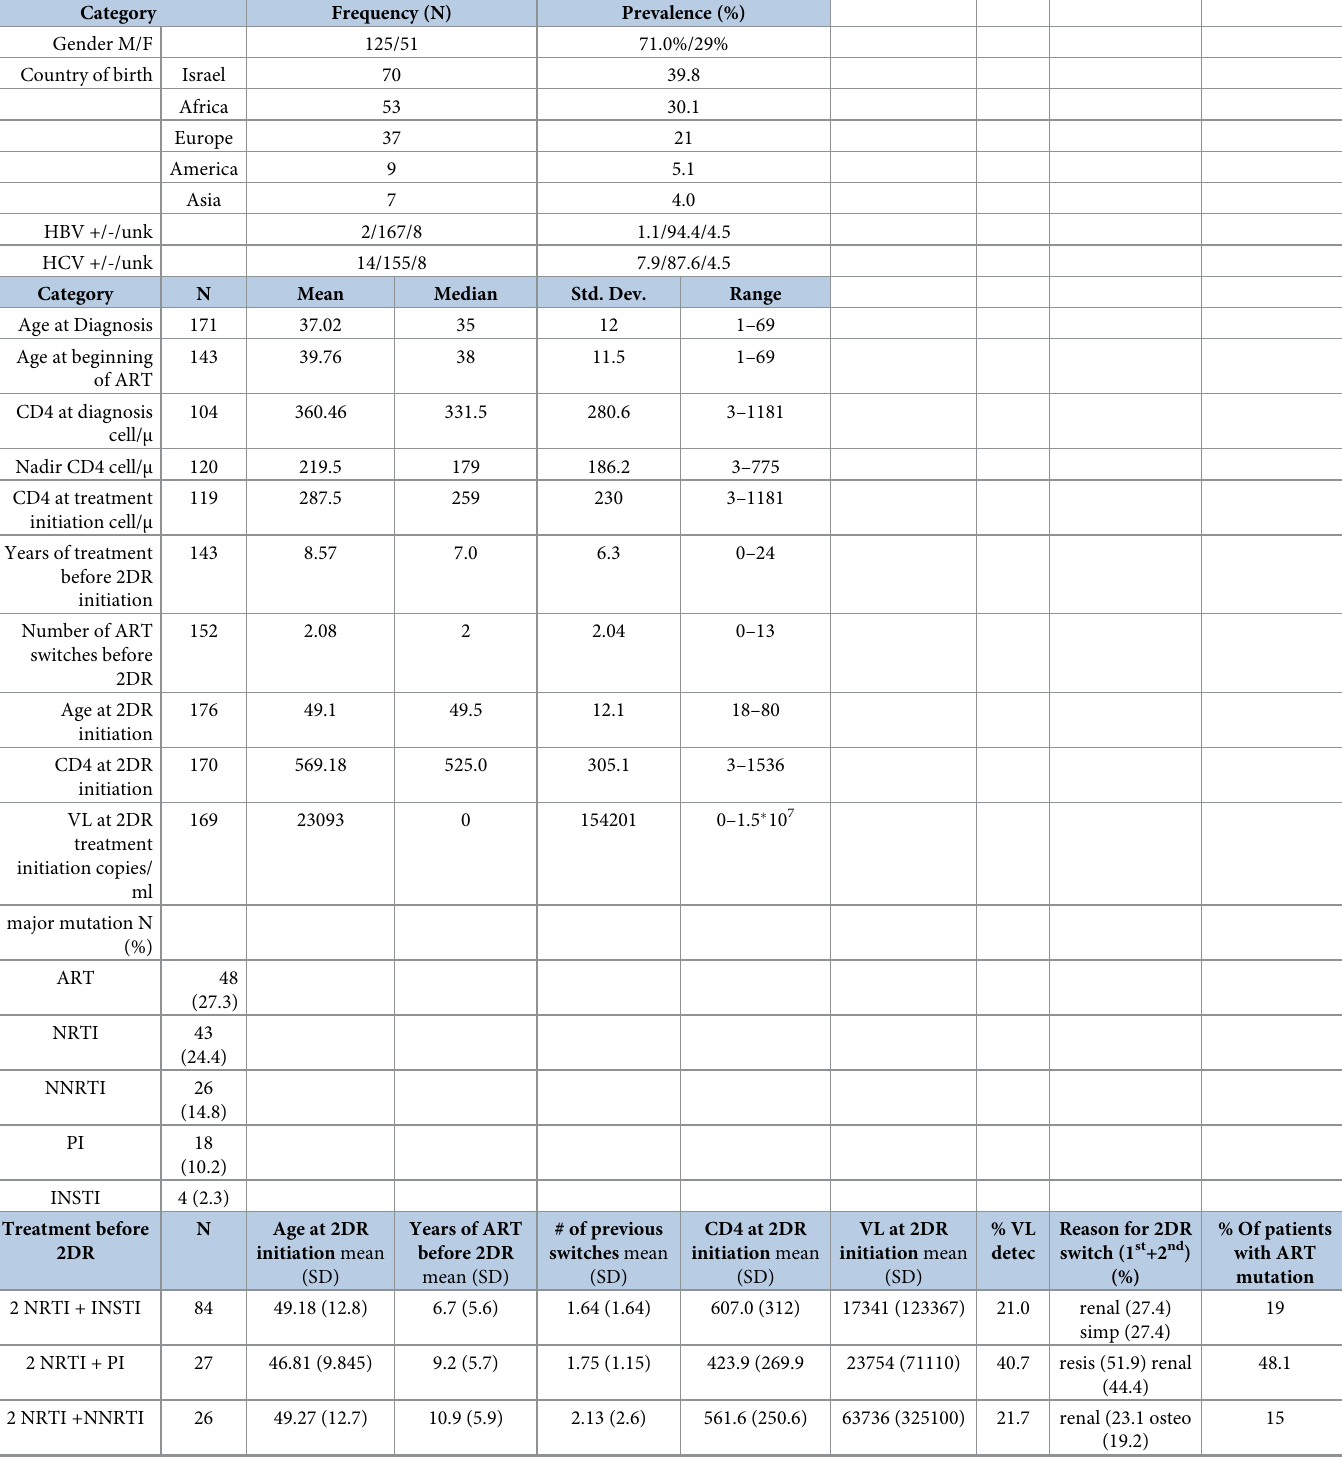
Table 1. Basic characteristics of study